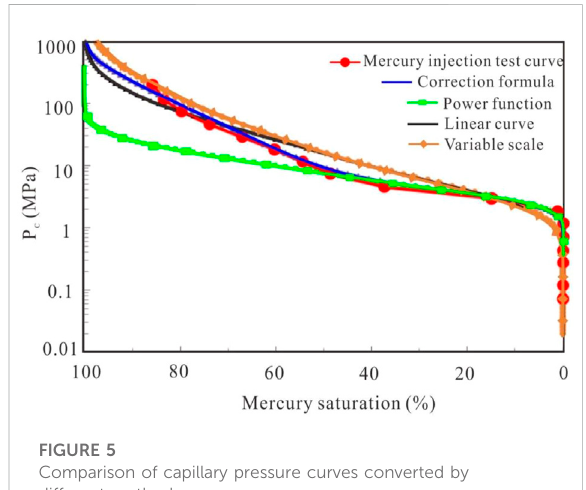
FIGURE 5 Comparison of capillary pressure curves converted by different methods.